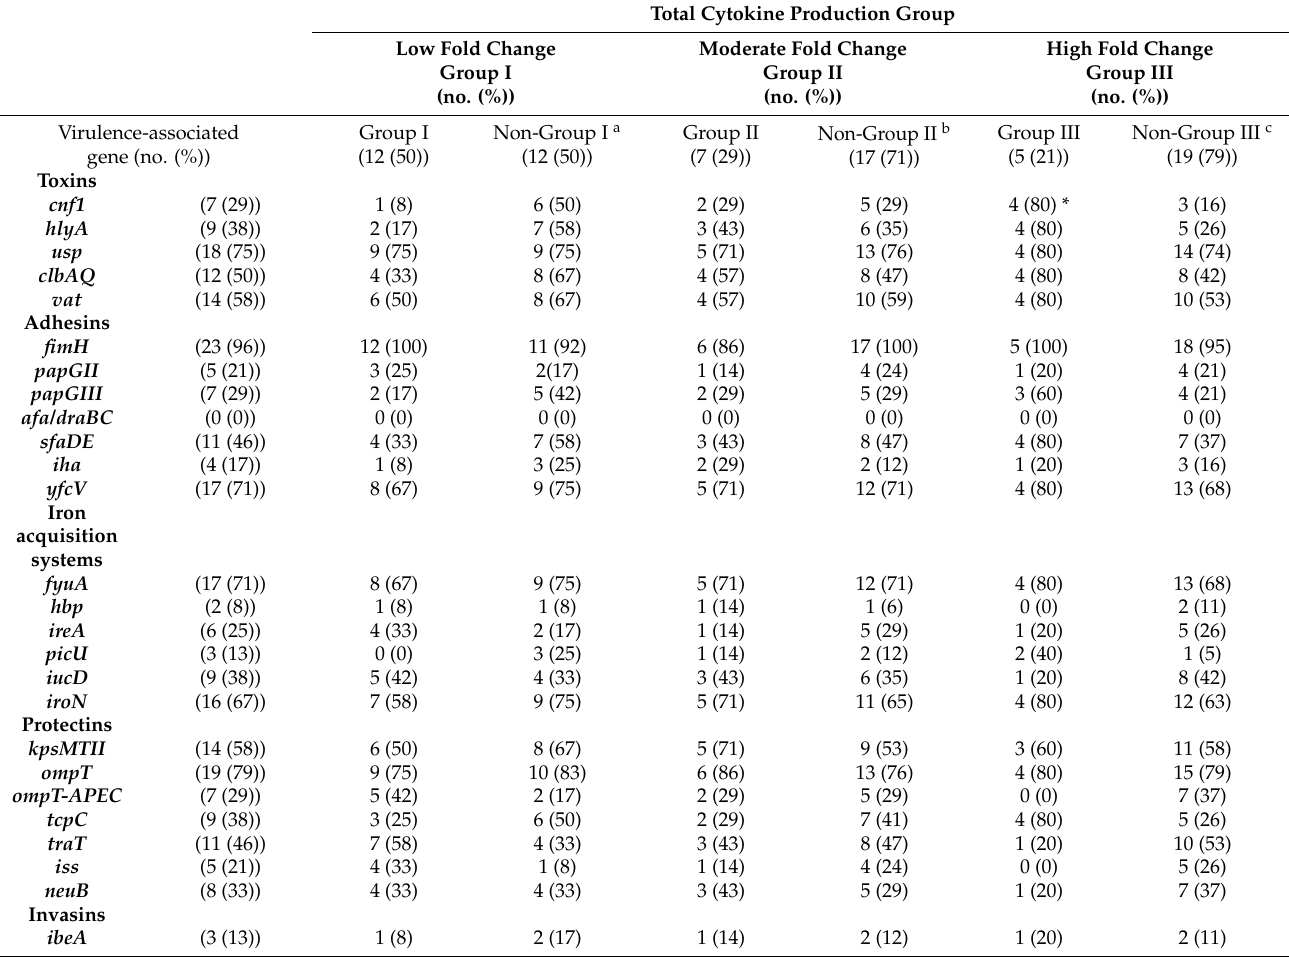
Table 3. Distribution of virulence-associated genes among E. coli strain groups causing different intensities of NPU cell cytokine